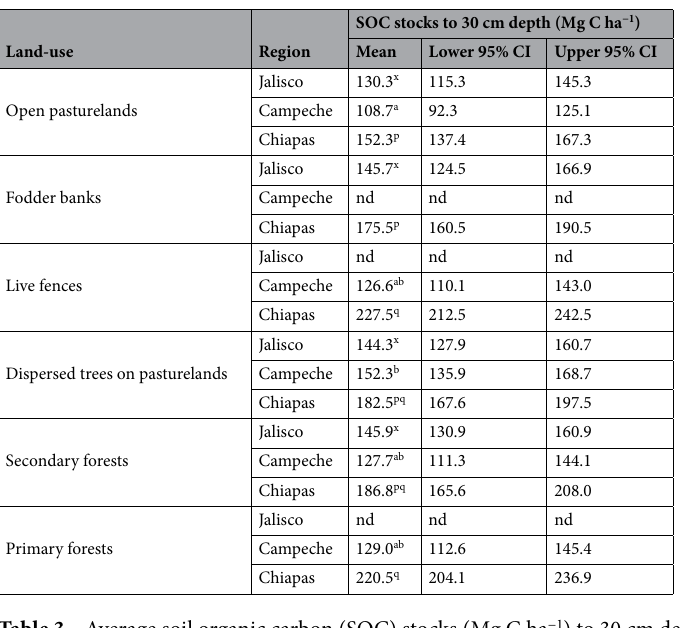
Table 3. Average soil organic carbon (SOC) stocks (Mg C ha −1 ) to 30 cm depth by land-uses across regions. Different letters indicate statistical differences between land-uses within the same region (Tukey HSD, p < 0.05). nd: data not available.